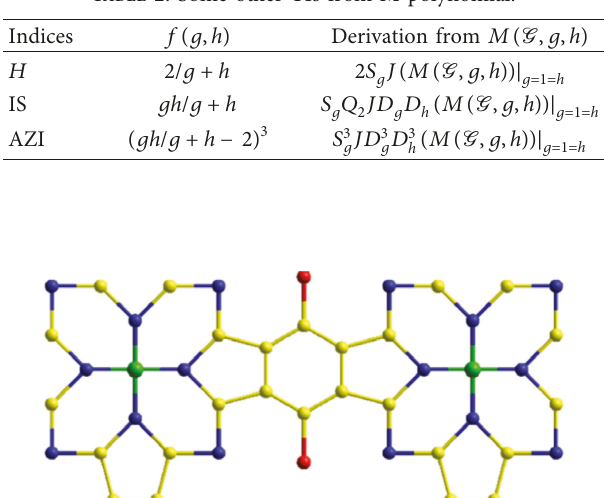
Table 2: Some other TIs from